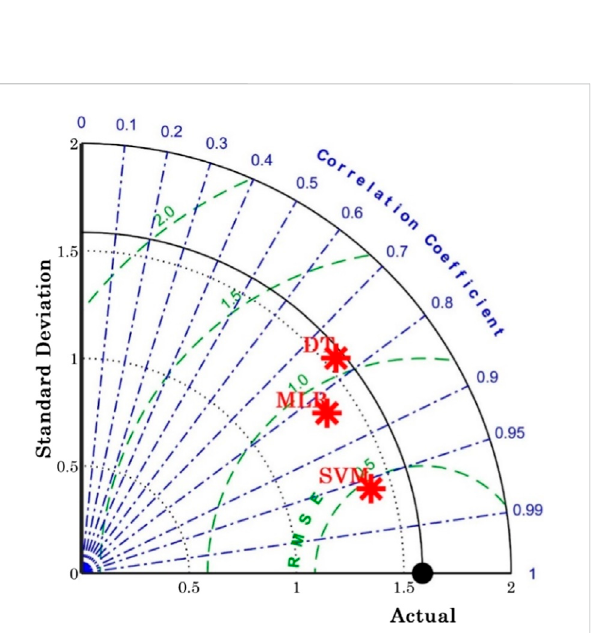
FIGURE 10 Box plot of prediction error of different models.